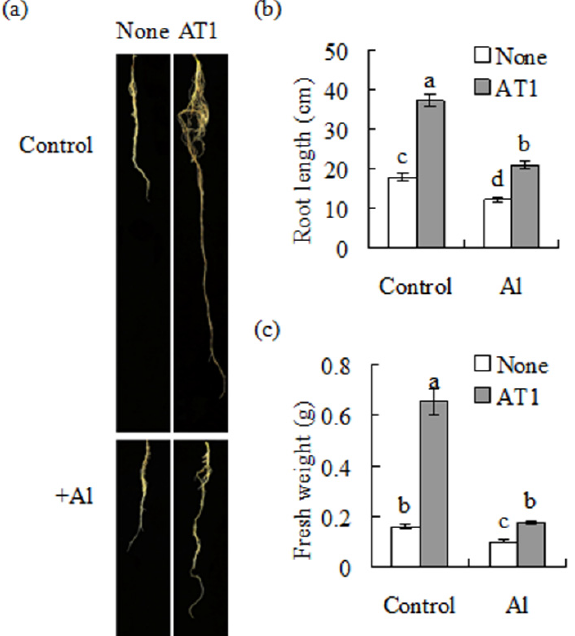
Figure 3. Analysis of the root growth in alfalfa, as affected by rhizobia inoculation under Al stress conditions. The AT1 suspension culture in combination with 1 mM AlCl 3 , or without AlCl 3 as a control, was rhizospherically applied to seedlings of alfalfa 7 d after germination. The low-nitrogen nutrient was maintained at pH 4.3. Photographs of the roots were taken after 5 weeks ( a ), followed by measurements of the root length ( b ) and root weight ( c ). The data are means ± SE ( n = 18); the same letter above the column indicates no significant difference at p <